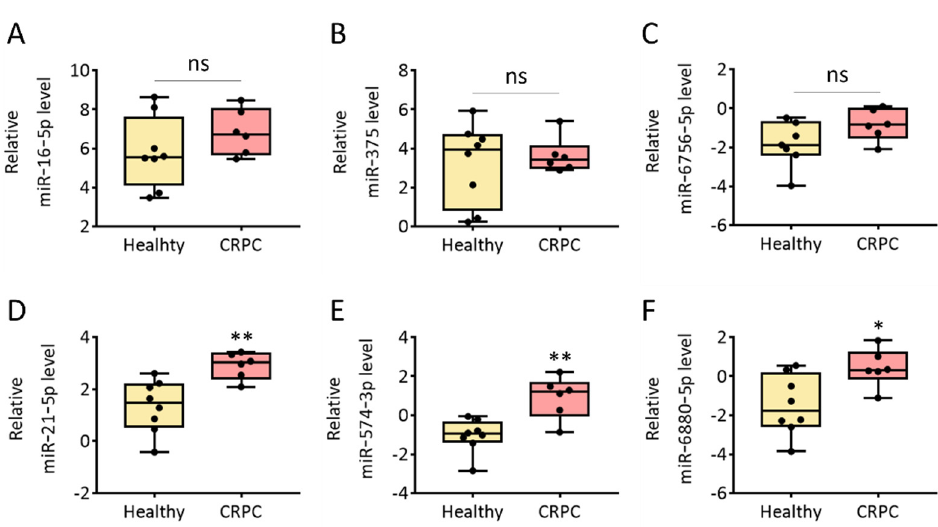
Figure 5. Relative expression levels of cancer-related miRNAs in urinary EVs from healthy donors and patients with CRPC. ( A ) miR-16-5p, ( B ) miR-375, ( C ) miR-6756-5p, ( D ) miR-21-5p, ( E ) miR-574-3p, and ( F ) miR-6880-5p in urinary EVs from healthy donors and patients with CRPC analyzed using RT-PCR and normalized ( Δ C T analysis) to expression levels for the U6 snRNA gene and are shown as log2 value. All values are presented as the median ± SD (* p < 0.05, ** p < 0.01, ns: no significance; n = 6–8).